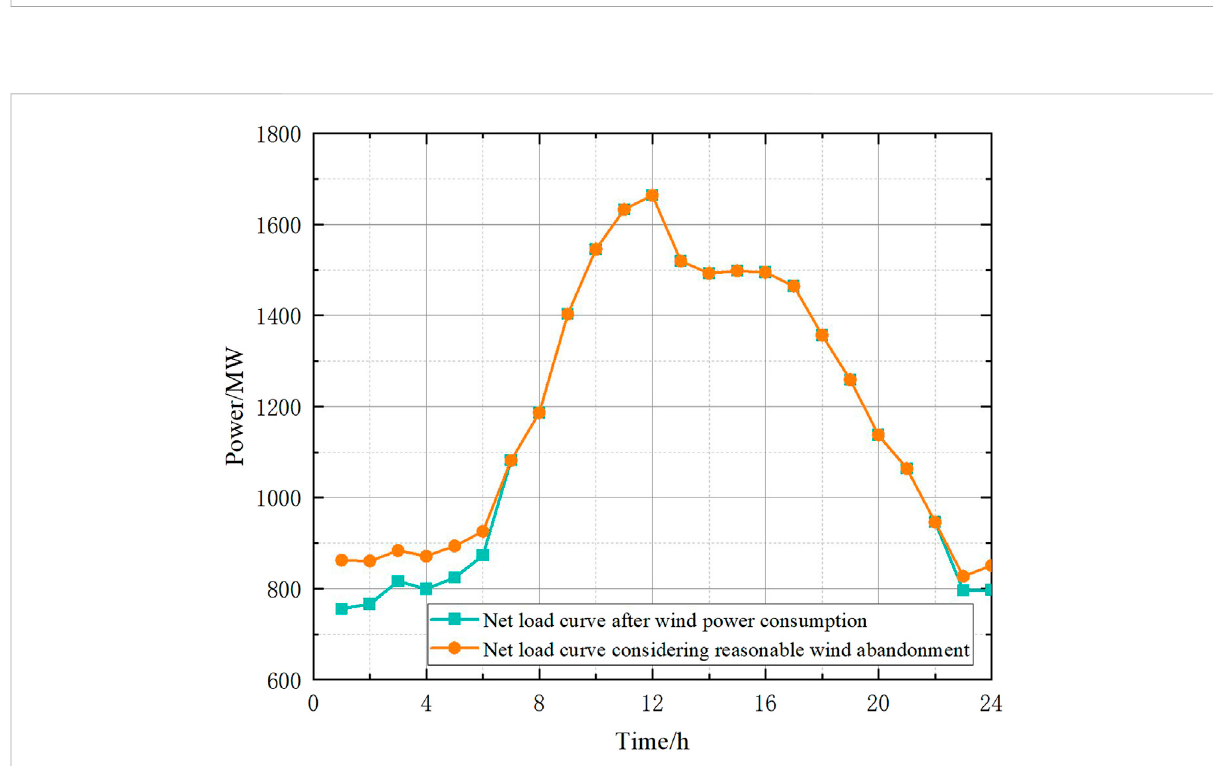
FIGURE 9 Net load curve before and after reasonable wind